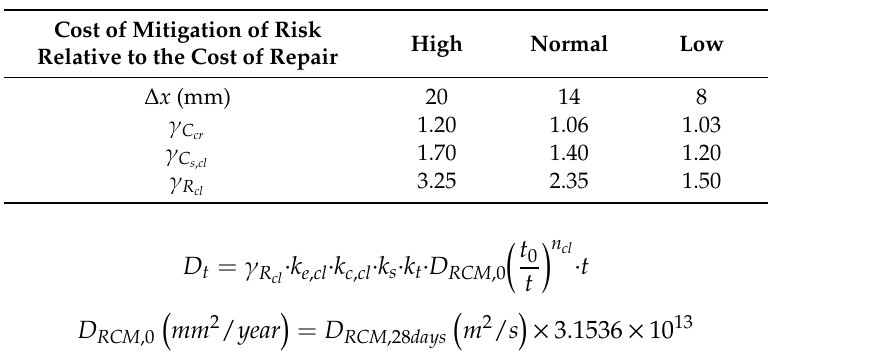
Table 9. Partial factors for structures in a marine environment.